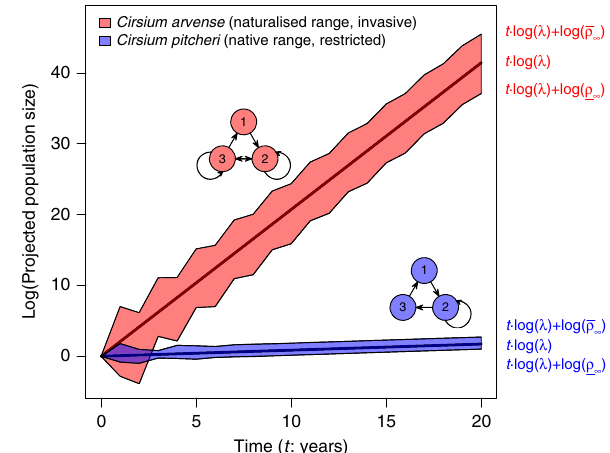
Fig. 1 Projections of stable and transient population dynamics of two thistle species. Cirsium pitcheri (blue) is a non-invasive species whose life cycle in the native range is discretised into three life-stages (1 = seedling, 2 = rosette, 3 = fl owering adult) 33 and measured as annual rates of per-capita transition among them. Cirsium arvense (red) is invasive (life-stages 1 = seed, 2 = rosette, 3 = fl owering adult) 34 . Predicted population dynamics (polygons) are initiated at initial population size of 1 and projected for twenty years. Solid central lines project dynamics of a population initiated at stable stage structure. Polygons capture the envelope of ampli fi cation and attenuation achieved by non-stable initial stage structures. Polygon boundaries are functions of time ( t ), stable rate of increase ( λ ), and demographic inertia ( (cid:1) ρ 1 and ρ ∞ describing ampli fi cation and attenuation, respectively). C. pitcheri , the non-invasive species, increases slowly and has a narrow envelope of ampli fi cation and attenuation. C. arvense , the invasive species, increases rapidly and has a wide envelope of ampli fi cation and attenuation. We ask, across plant species, can stable growth rates or demographic inertia, measured in the native range, predict the invasiveness of plants in their naturalised